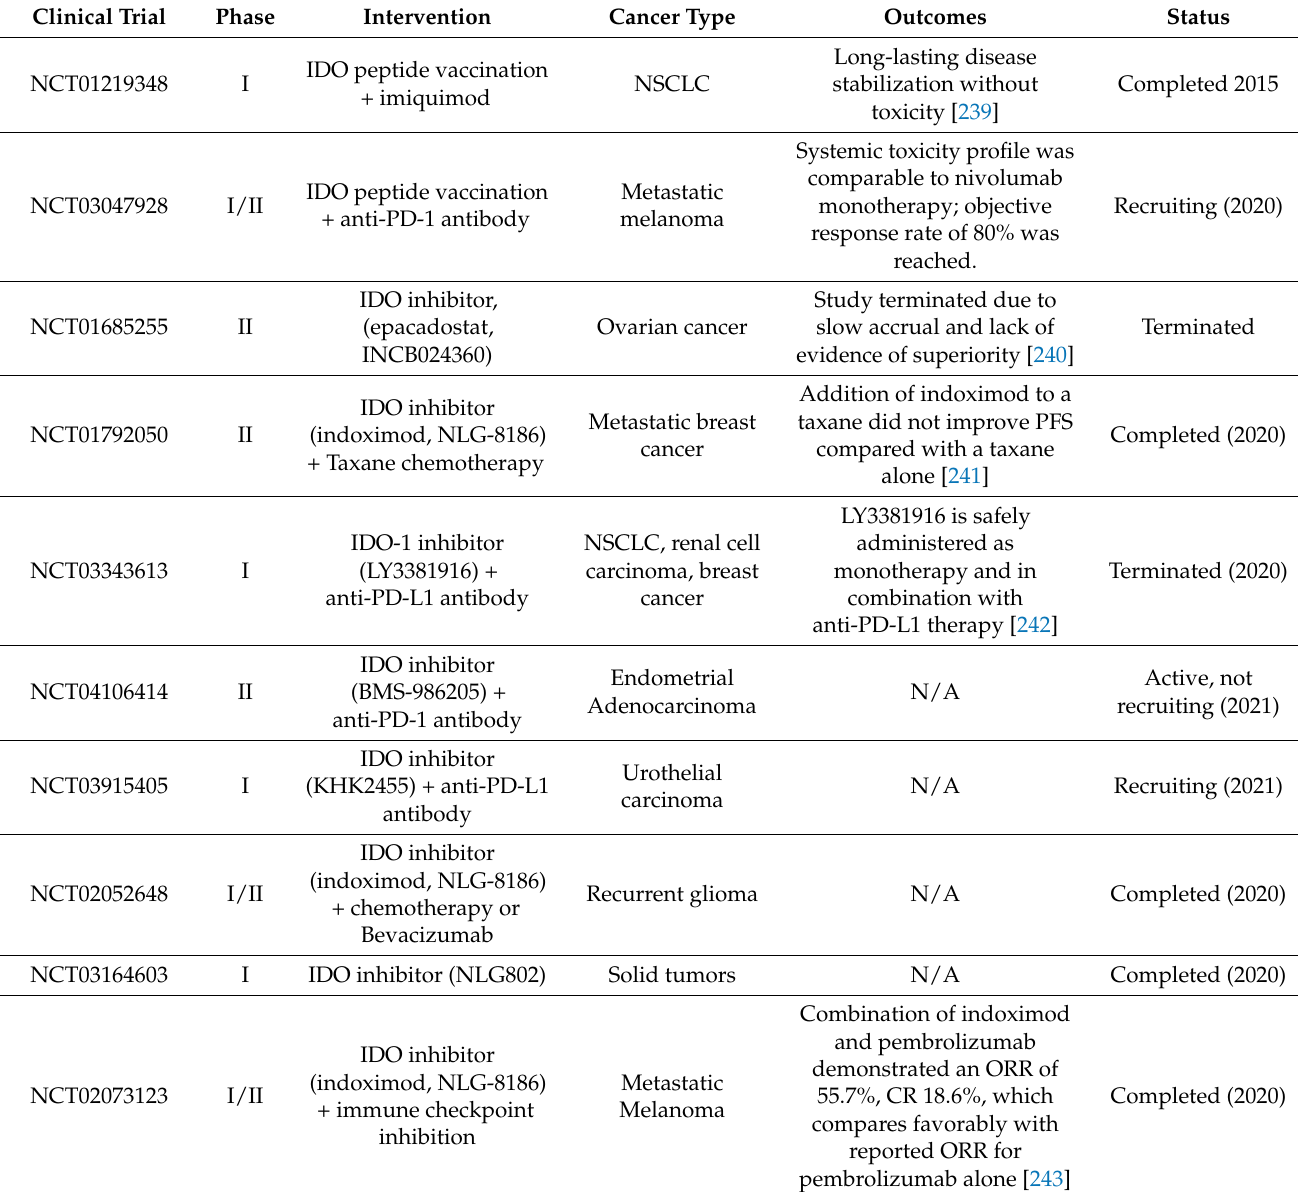
Table 4. Clinical trials targeting immunosuppressive metabolites in